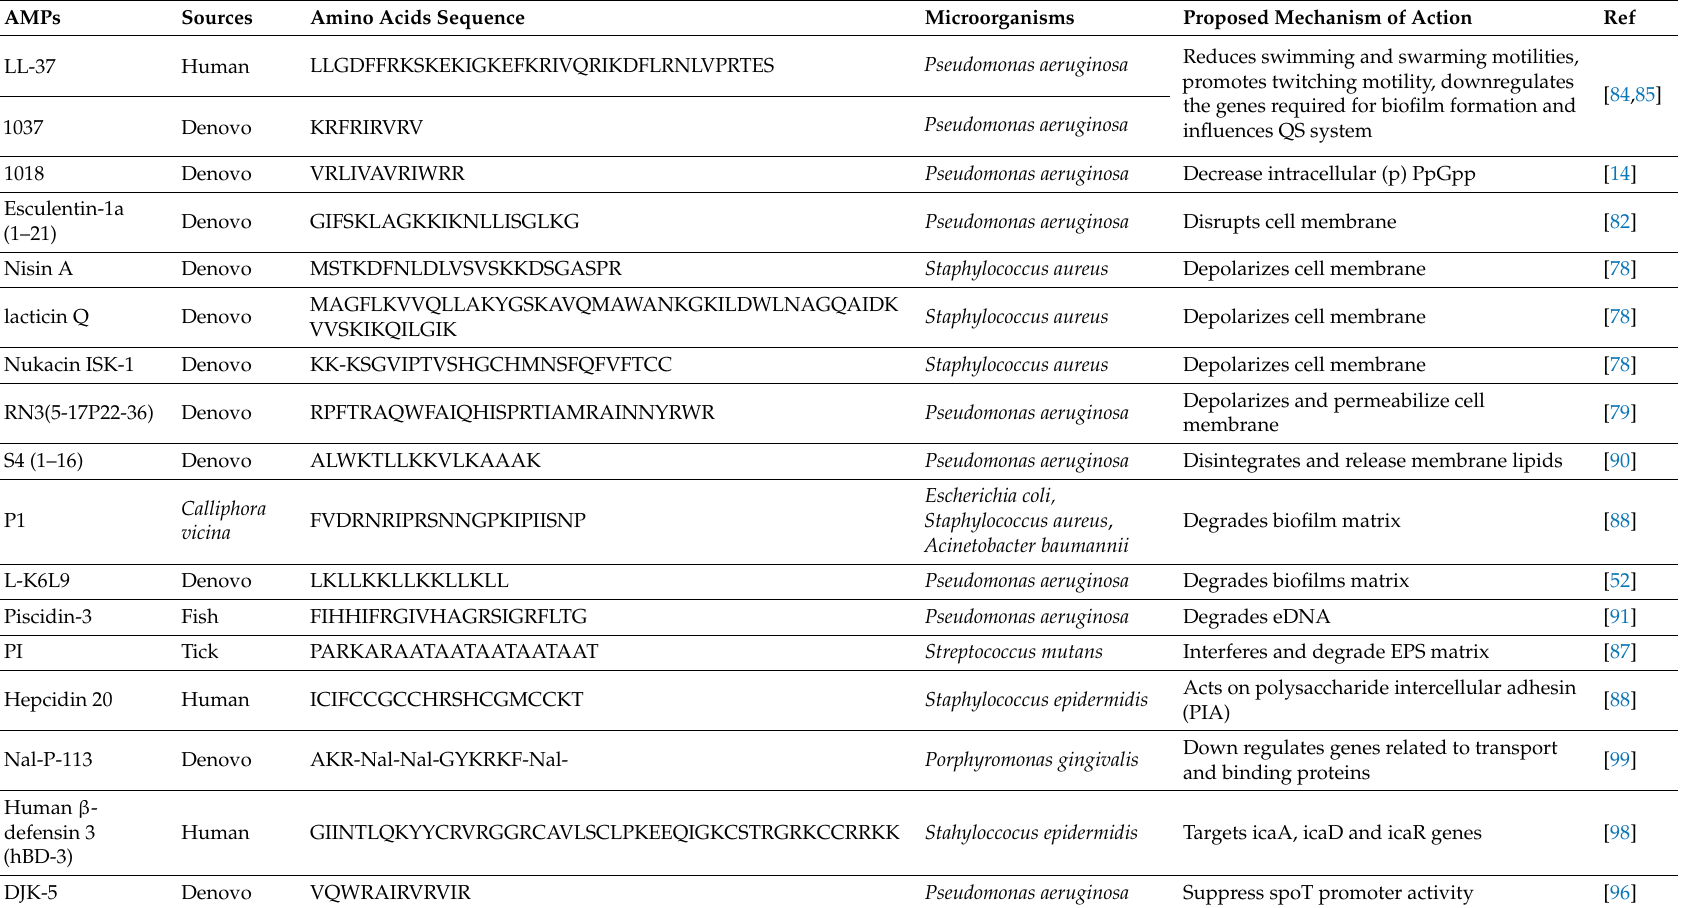
Table 1. Representative AMPs and their anti-biofilm mechanism of